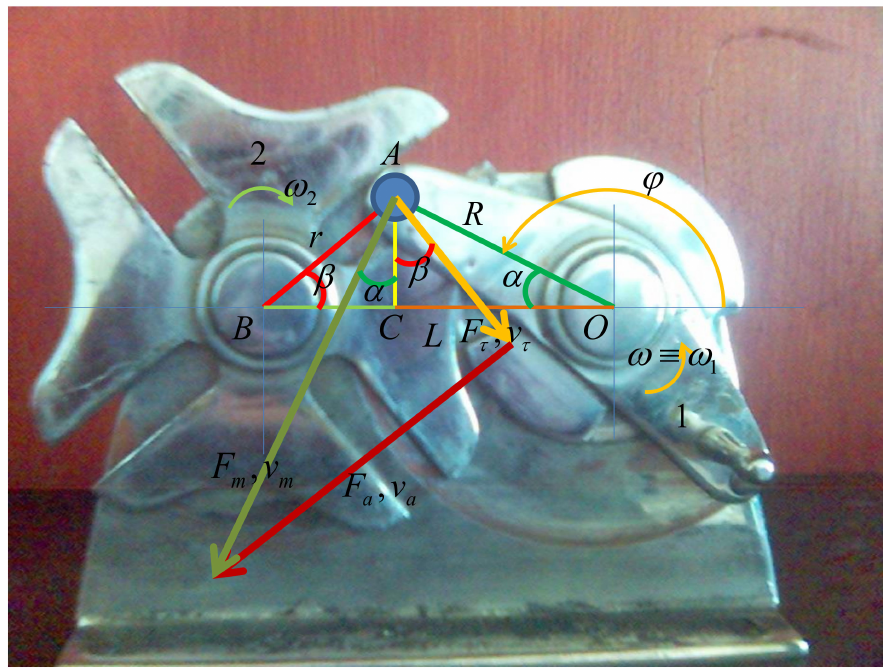
Figure 2. A Geneva driver